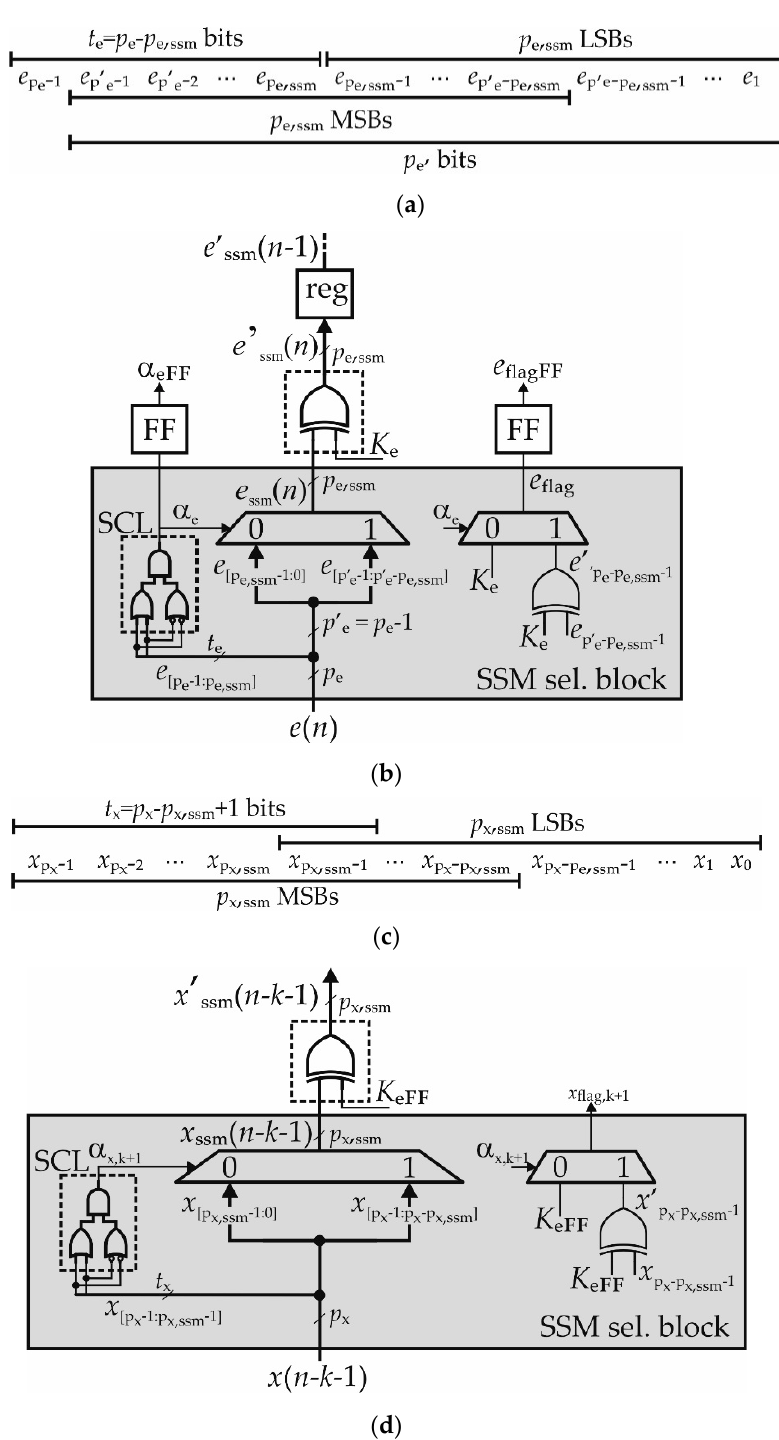
Figure 10. ( a ) Segmentation scheme for the error signal and ( b ) related SSM selection block. ( c ) Seg- mentation scheme for the ( k + 1)-th input sample and ( d ) related SSM selection block.